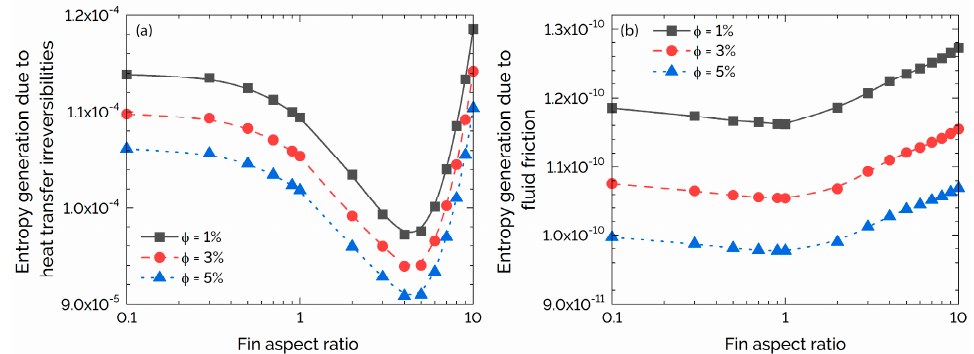
Figure 9. Effects of fin aspect ratio and nanoparticle concentration ( ϕ ) on entropy generation for CuO-water nanofluid: ( a ) entropy generation caused by heat transfer irreversibility and ( b ) entropy generation caused by fluid friction. The variations are illustrated for ϕ = 1%, 3%, and 5%, respectively, and fin area fraction of 0.05, as Re and Ra numbers are kept at 10 3 and 10 5 , respectively.